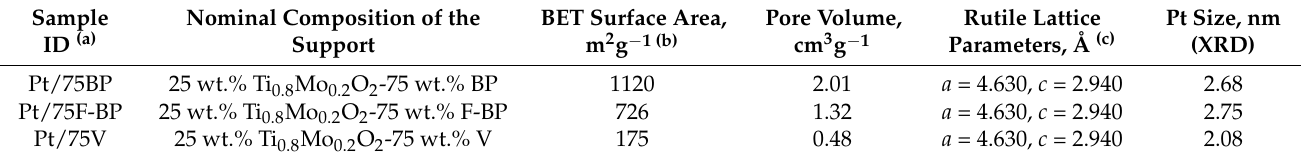
Table 1. Denomination, composition, and characterization of the composite supports and the related Pt catalysts by nitrogen adsorption and XRD